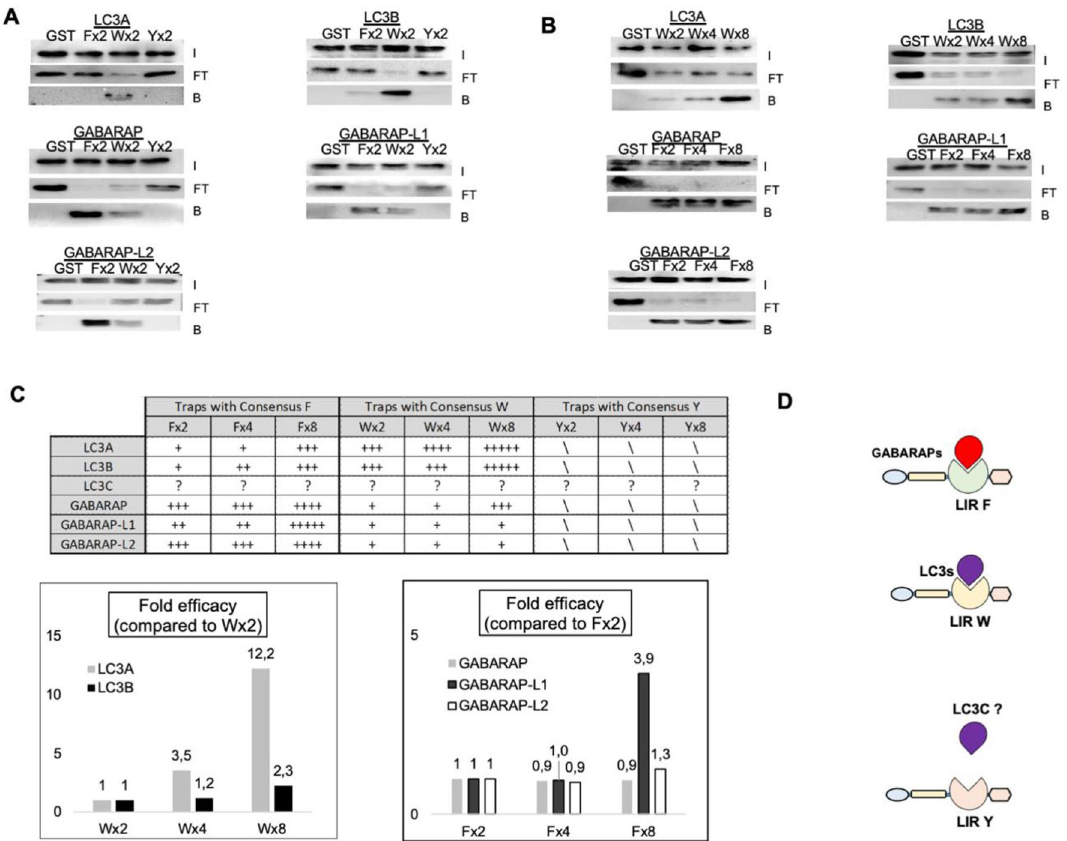
Figure 3. Cooperative effects and binding preferences of LC3 traps towards LC3/GABARAP proteins captured from cell extracts. (A ) Cell extracts from twenty millions of ZBR cells treated 8 h with BafA were incubated 4 h with 100 µg of purified Fx2, Wx2, Yx2 LC3 traps. Captured material was analyzed by Western blot using specific antibodies against distinct LC3/GABARAP proteins as indicated. Input (I), flow through (FT) and bound (B) fractions are shown. ( B ) Using similar settings than in ( A ), 100 µg of purified LC3 traps carrying 2, 4 and 8 LIR motifs were incubated with ZBR cell extracts. Western blot analysis of the input (I), flow through (FT) and bound (B) fractions using specific antibodies for the indicated LC3/GABARAP proteins as indicated. These experiments were performed twice. Images of PVDF membranes were cut after antibody hybridization to optimize spaces. ( C ) Analysis of the results obtained from the capture obtained in A and B. Interactions are qualitatively annotated in the table as (+) low to (+++++) high interactions. No interaction is indicated as (\). Low levels of LC3C in these cells did not allow the detection of this protein in total cell extracts (Fig. S4). The lower panel shows the fold efficacy of distinct W and F Traps towards distinct LC3/GABARAP proteins, compared to traps contining 2 LIR domains. ( D ) Summary of the LC3/GABARAP proteins captured with distinct LC3-traps. Endogenous GABARAP proteins were preferentially captured by LIR-F traps, while LC3 molecules were best captured by LIR-W traps, except for LC3C that we could not evaluate. LIR-Y trap did not capture any of these proteins under the experimental conditions Input, flow through and bound fractions were analyzed by Western blot using anti-GFP antibodies. Our results indicated that both LC3-traps Fx8 and Wx8 interacted with LGG-1, while only LC3-trap Wx8 interacted with